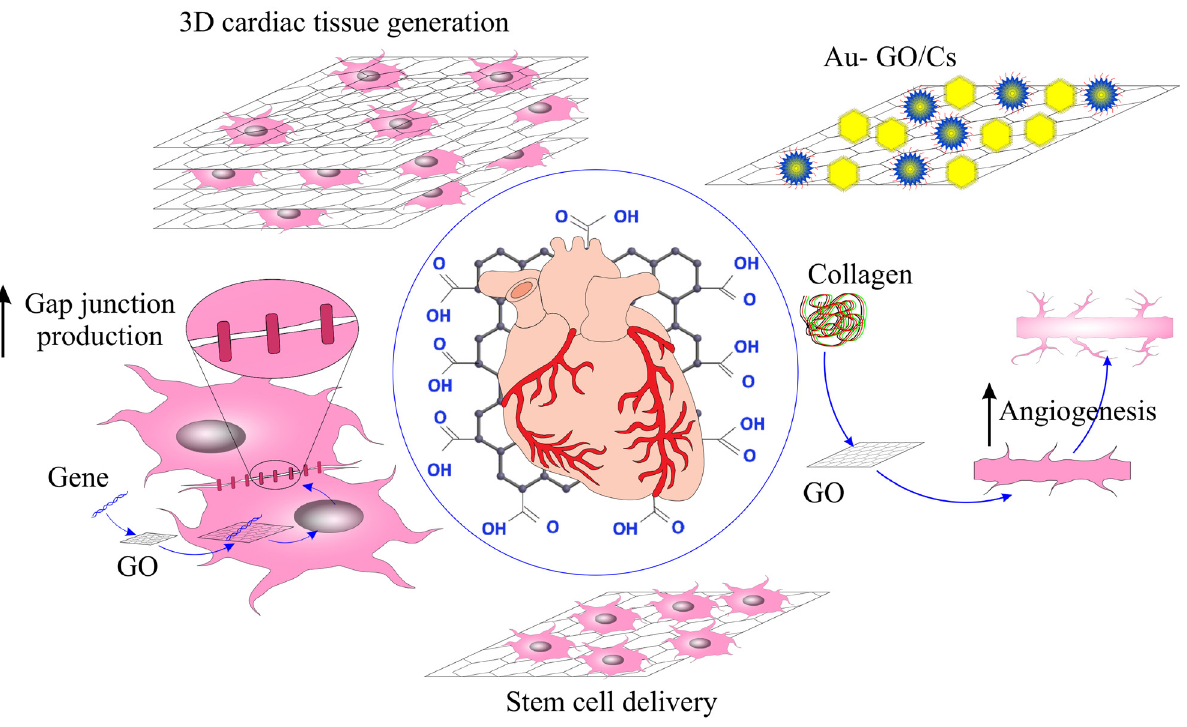
Figure 2: A schematic diagram of multiple applications of graphene oxide in cardiac